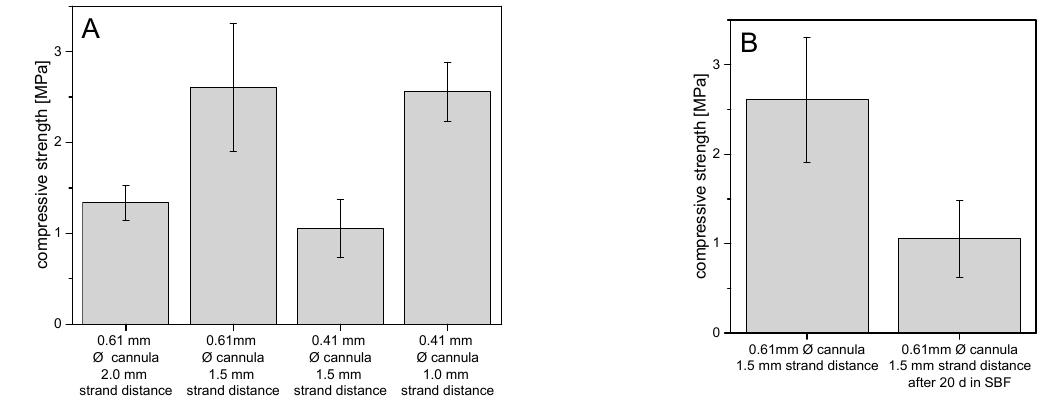
Figure 8. Compressive strength of printed scaffolds ( A ) with variation of strand distance and cannula diameter and ( B ) before and after immersion in SBF solution for 20 days.